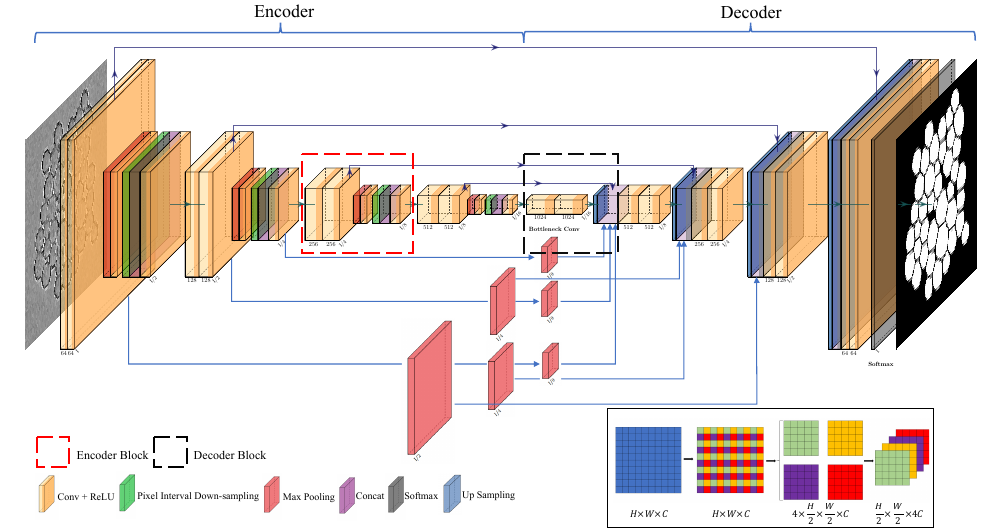
Figure 2. The structure of the proposed